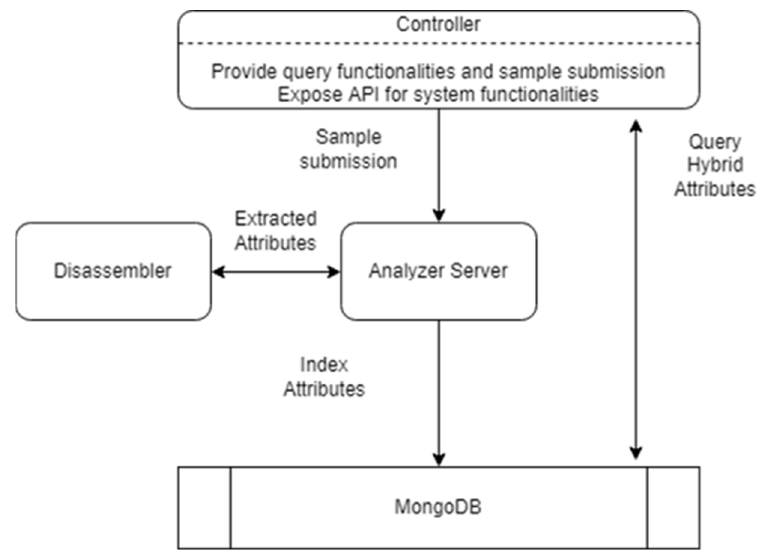
Figure 17. Static ransomware detection system block diagram.